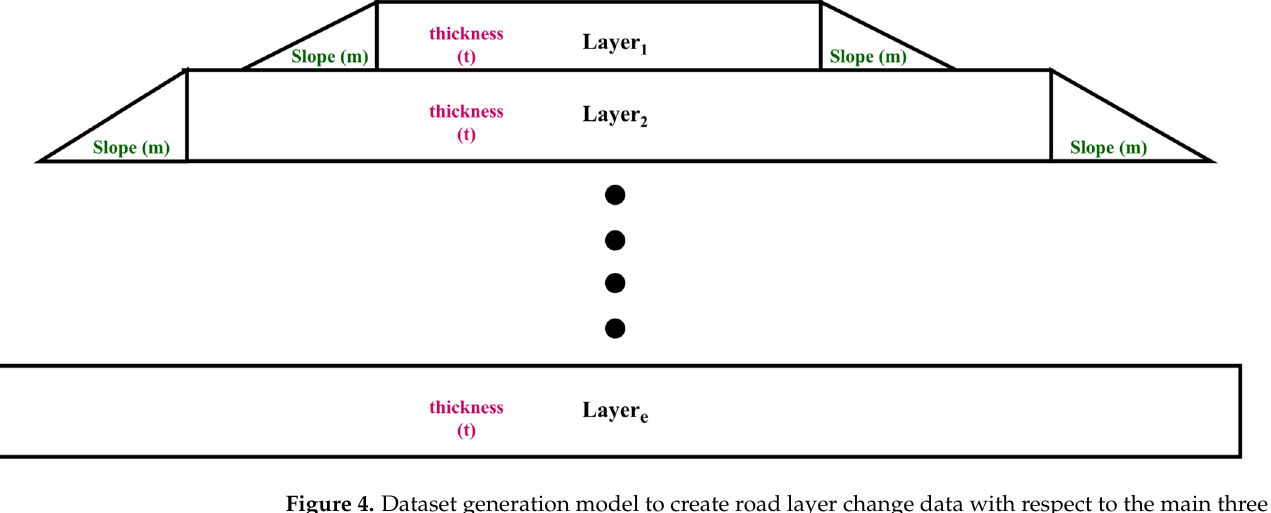
Figure 4. Dataset generation model to create road layer change data with respect to the main three variables (road layer, thickness, and slope between two adjoining road layers) .